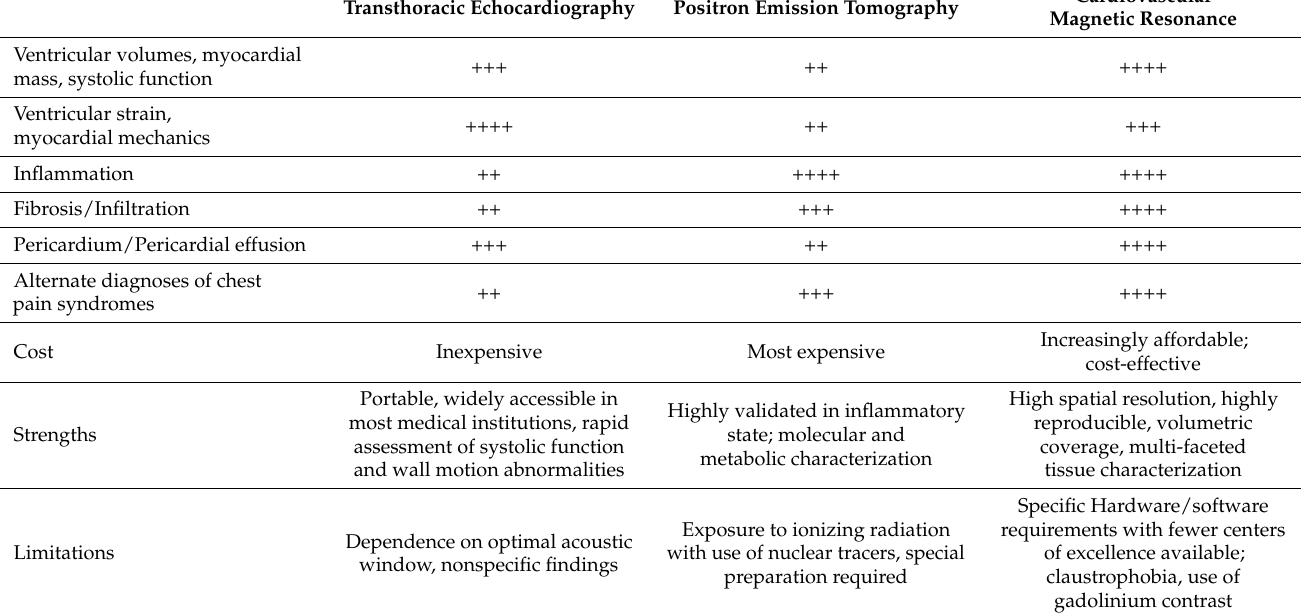
Table 1. An Overview of Imaging Modalities Used in the Evaluation of Patients Presenting with